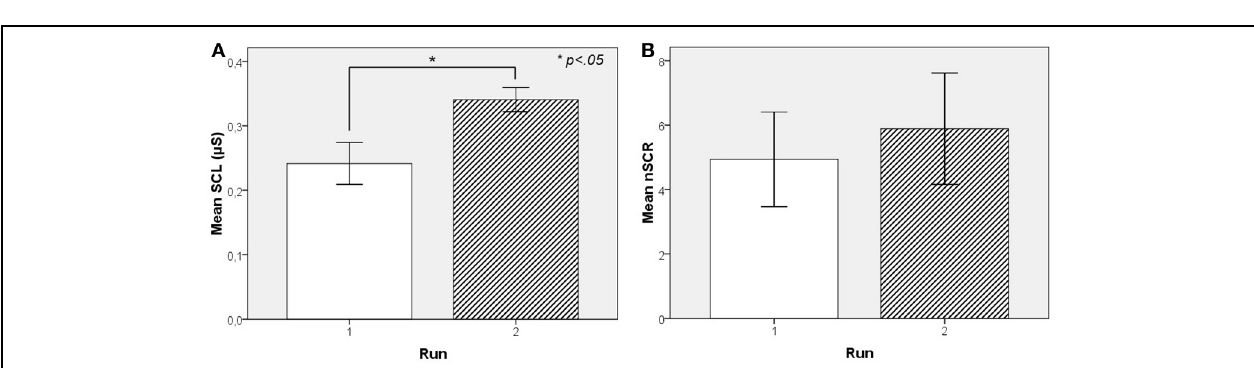
FIGURE 2 | Effect of Familiarity on mean pleasure ratings (A) and mean arousal ratings (B) from Experiment 1B. All differences are statistically significant.